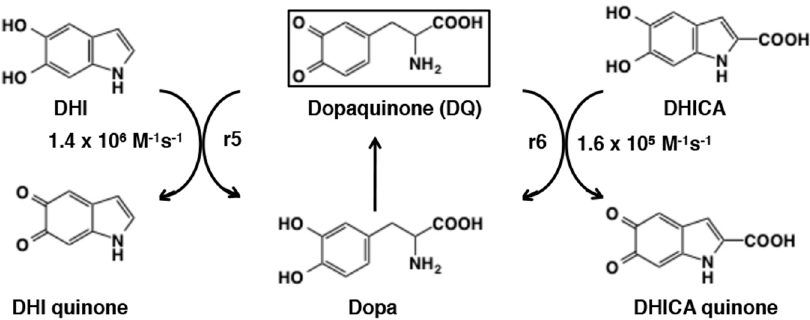
Figure 29. Kinetics of late stages of eumelanogenesis from DHI and DHICA. Note that dopaquinone (DQ) acts again here as a redox exchanger [156].